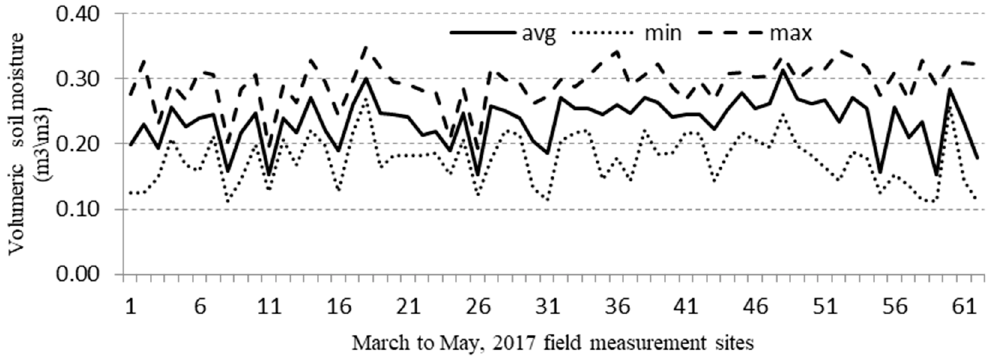
Figure 3. Observed soil moisture of each point during six passes of the satellite estimated using the gravimetric method during 2017.